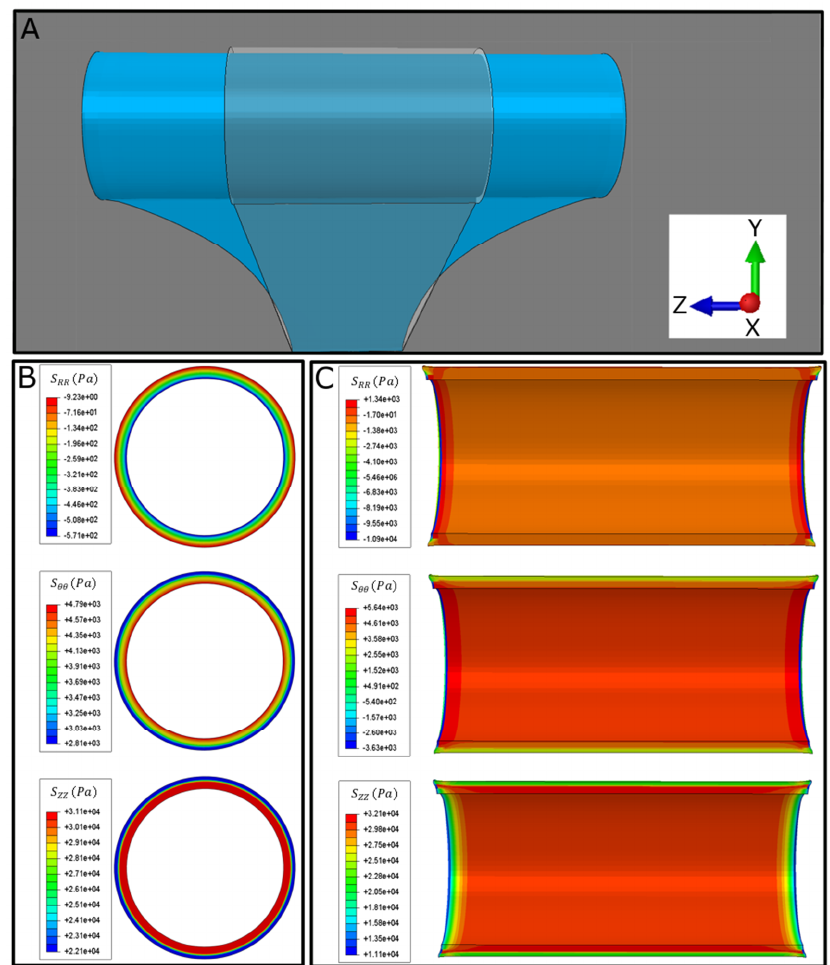
Figure 6. Computational model results after lengthening of distracted segment due to applied mechanical forces at both ends. ( A ) Representative frontal view of model. ( B , C ) Stress representation of computational model in R , θ , Z